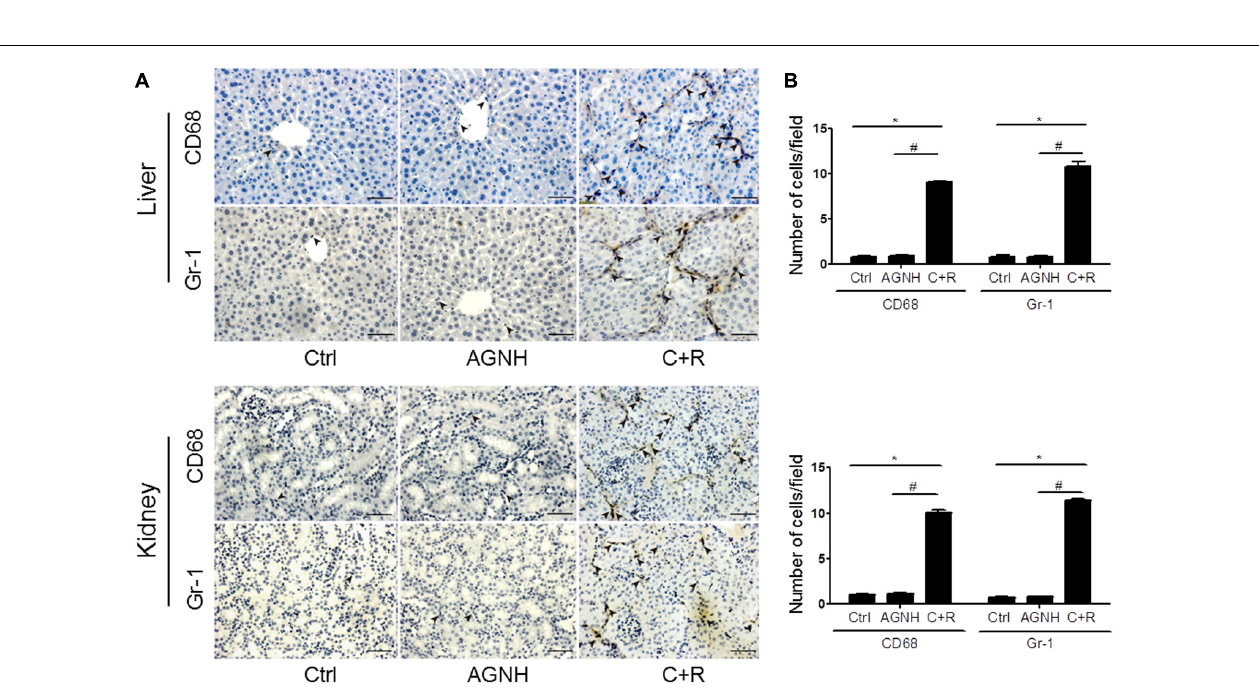
FIGURE 2 | (A) Representative photomicrographs showing infiltrating CD68-positive macrophages or Gr-1 positive neutrophils (indicated by arrowheads) in the liver and kidney tissues of mice from three different groups: Ctrl, saline operated; AGNH, An-Gong-Niu-Huang Wan 2.5 g/kg/d treatment for consecutive 28 days; C+R, cinnabar and reaglar 0.14 + 0.14 g/kg/d combinational treatment for consecutive 28 days. Scale bar: 50 µ m. (B) Quantification of the number of CD68-positive macrophages or Gr-1 positive neutrophils per high-power field in different groups. Each bar represents mean ± SD for 6 mice. ∗ P < 0.05 saline control versus cinnabar and reaglar co-administration; # P < 0.05, An-Gong-Niu-Huang Wan versus cinnabar and reaglar co-administration.